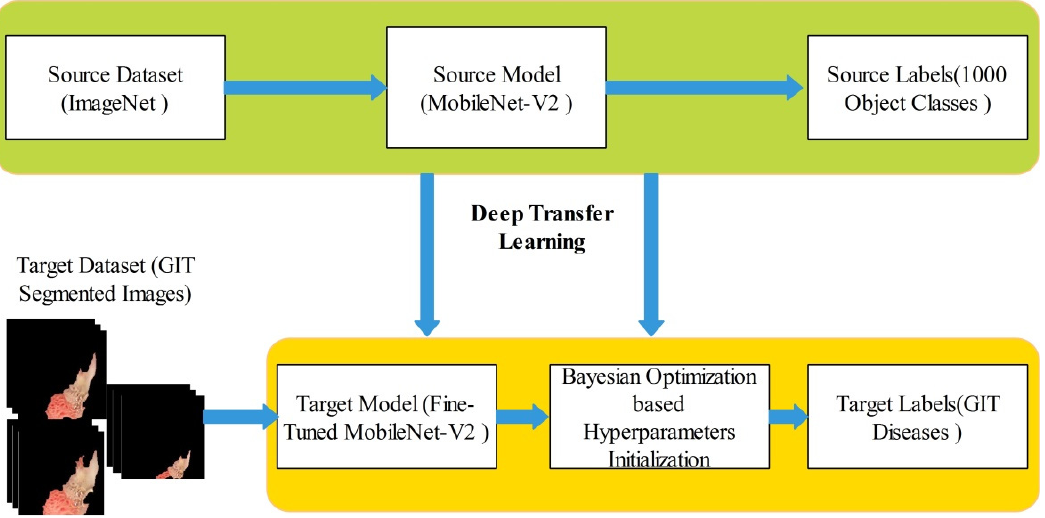
Figure 6. Deep TL and BO-based training of fine-tuned model on segmented GIT disease images.